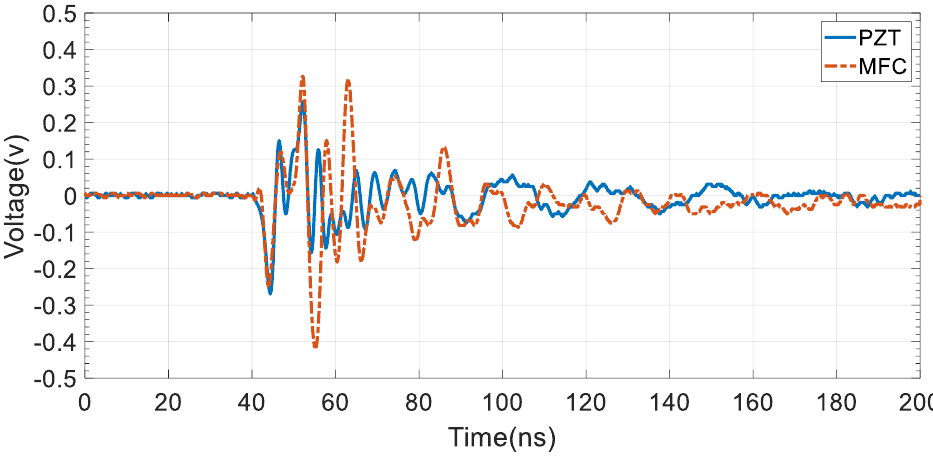
Figure 5. Partial discharge signals in the time domain that were obtained from the AE sensors.